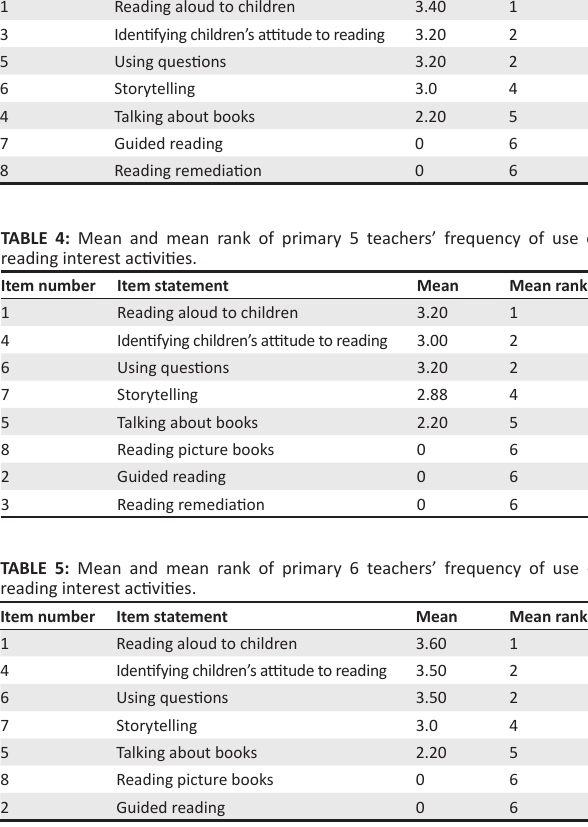
TABLE 3: Mean and mean rank of primary 4 teachers’ frequency of use of reading interest activities. Item number Item statement Reading aloud to children